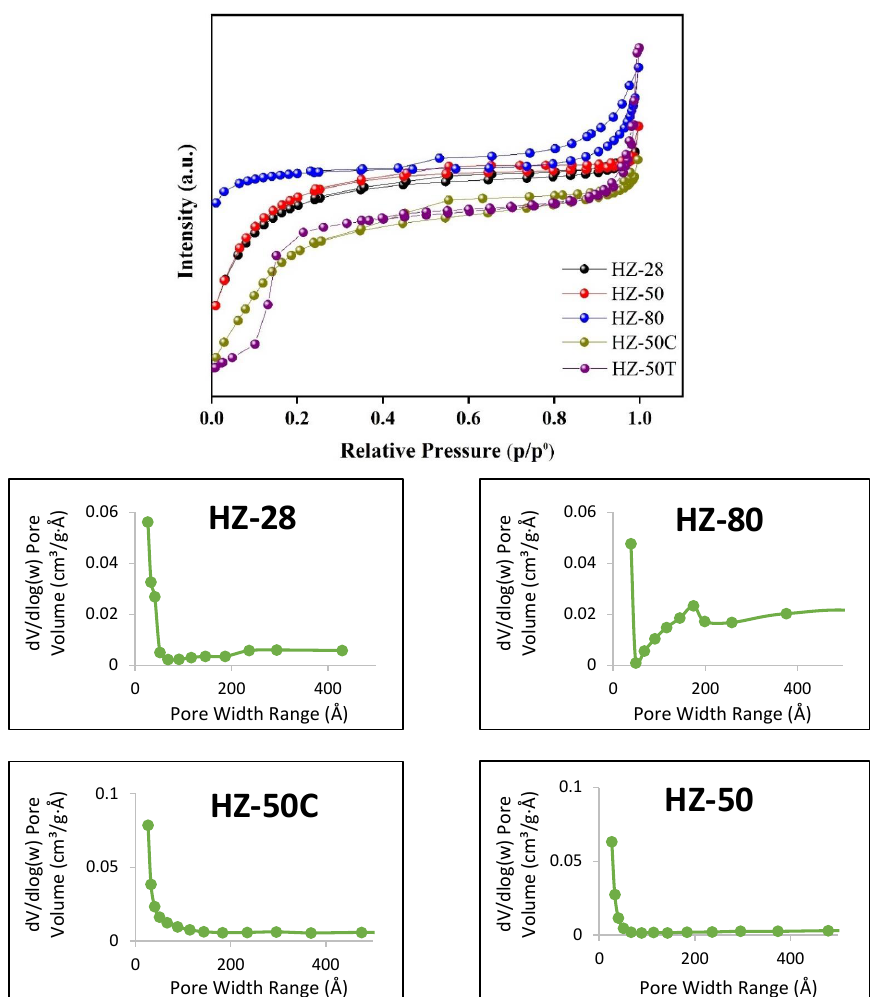
Fig. 5. The N 2 adsorption and desorption isotherms of zeolites & BJH by the BET method Fig. 5. The N adsorption and desorption isotherms of zeolites & BJH by the BET 2